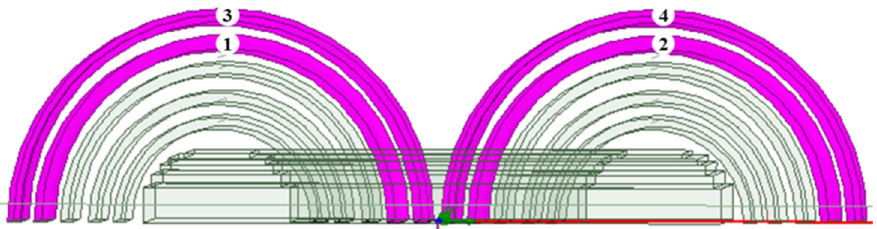
Figure 14. Positions 1–4 of the transformer primary windings simulation model. when the residual flux magnetization B r = 1.24T and the closing angle θ = 0°.